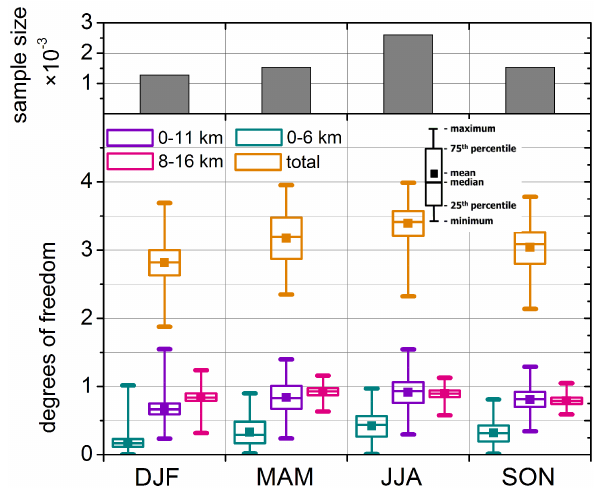
Figure 4. Bottom panel: statistics for DOFS for selected partial columns as indicated in the legend, separated by season (southern hemispheric stations offset by 6 months). The boxes represent the 25th and 75th percentiles and the whiskers the minimum and max- imum values of the distribution. All IASI-TOE scenes as indicated in Table 1 are included. Top panel: sample size for calculating the statistics in the bottom panel. The overall sample size is